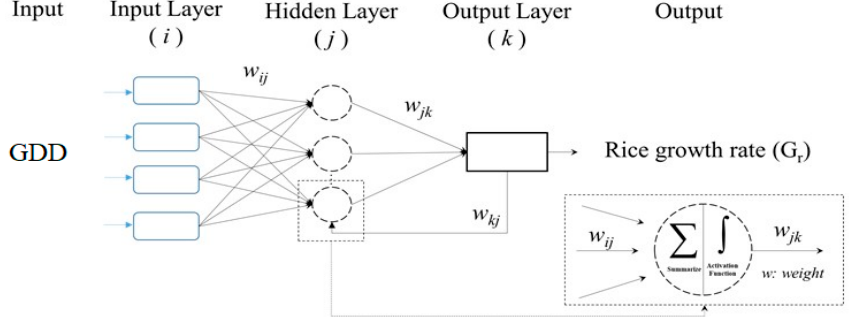
Figure 3. The working architecture of the backpropagation neural network (BPNN) model.